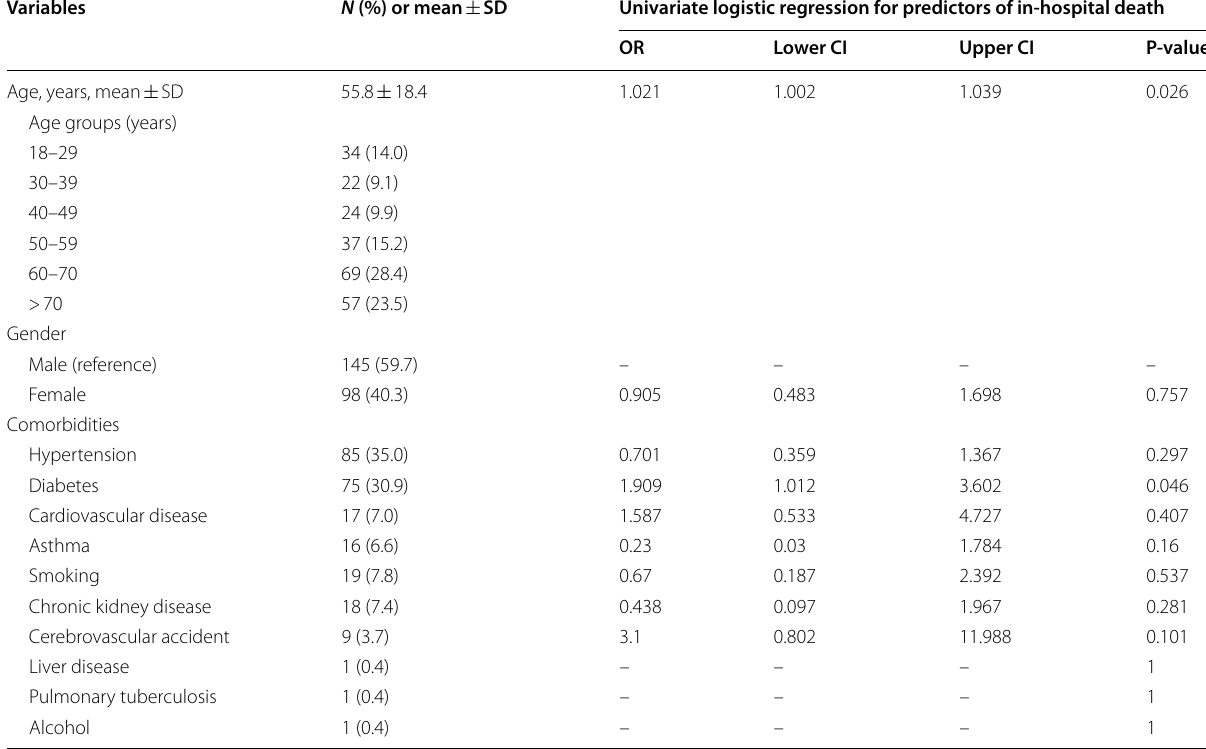
Table 1 Sociodemographic characteristics and comorbidities of patients with COVID-19 and their association with the final outcome ( N 243) =